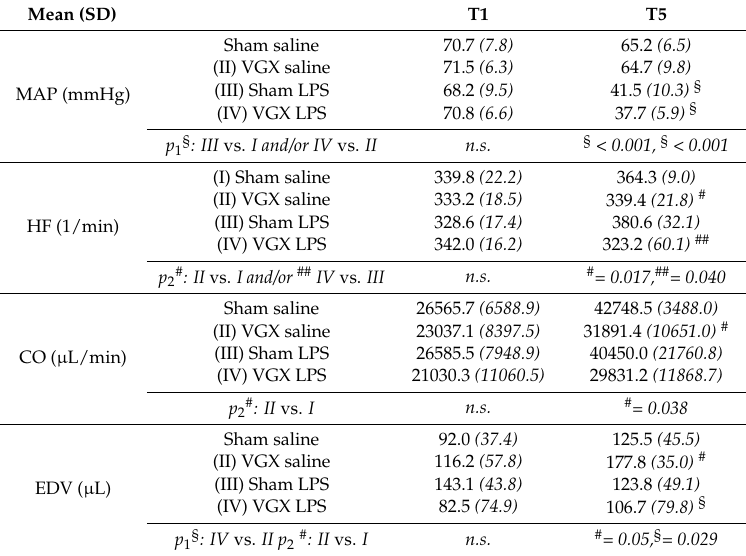
Table 2. Hemodynamic parameters.